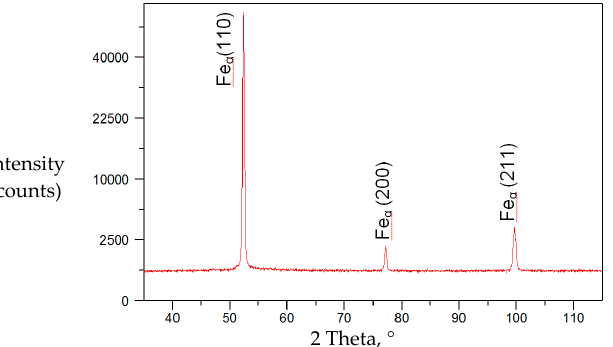
Figure 7. X-ray diffraction of the butt weld made in steel S700MC using laser beam welding and a linear energy of 5 kJ/cm.